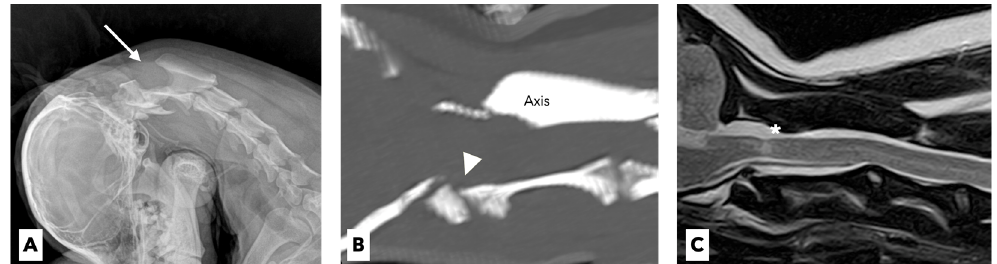
Figure 1. Lateral flexed radiographic image ( A ) showing that the space (arrow) between the spinous process of axis and the dorsal arch of atlas is increased. Sagittal-plane CT imaging ( B ) reveals a hypoplastic dens (arrowhead) of the axis with prominent compression of the spinal cord. T2-weighted magnetic resonance image ( C ) reveals moderately compressed spinal cord and inflammatory changes of the adjacent spinal cord parenchyma (asterisk).